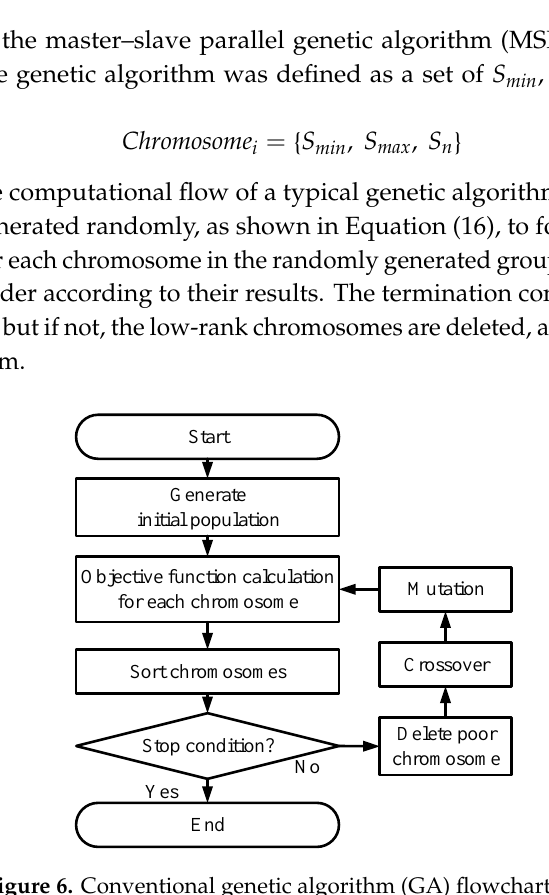
Figure 7. Crossover and mutation operation process.